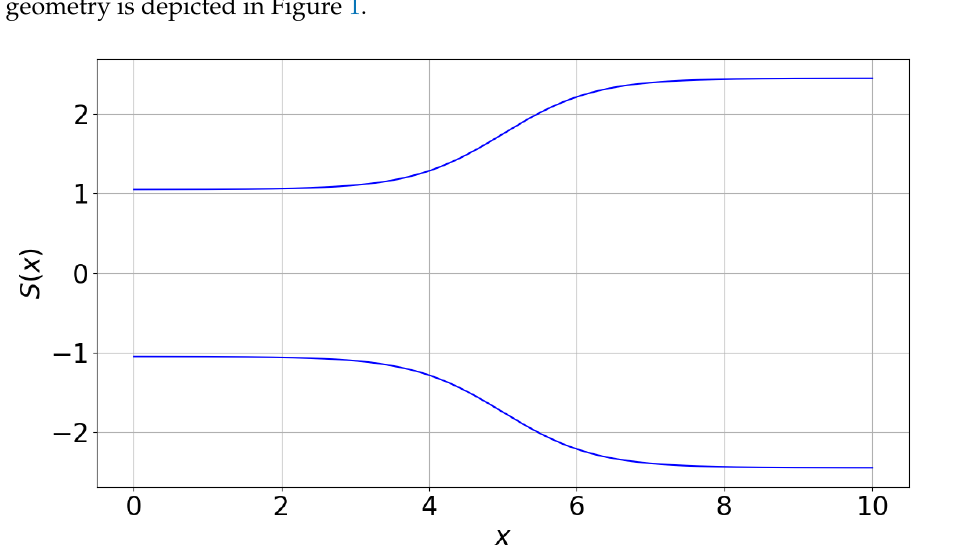
Figure 1. Baseline quasi-1D